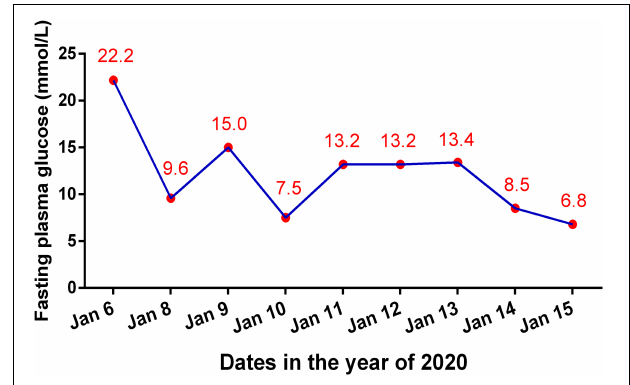
FIGURE 2 | Changes of fasting plasma glucose level during the hospital stay because of diabetic ketoacidosis.